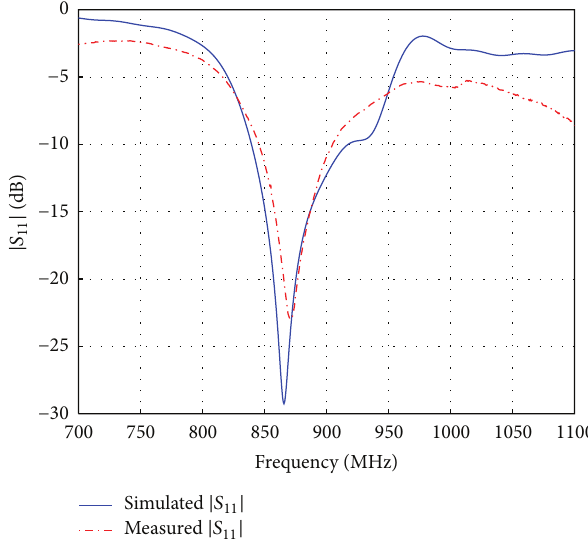
Figure 3: Simulated and measured |𝑆 11 | of the segmented loop antenna.